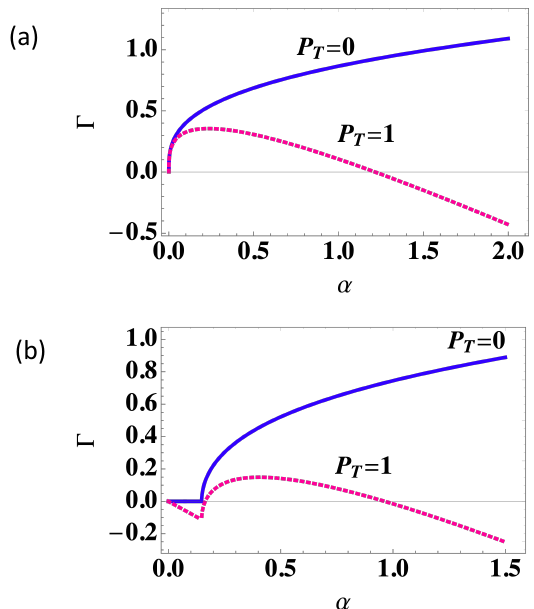
Figure 2. Thermal effects: Damping rate Γ = (cid:61) ( Ω ) , for a fixed value of (cid:60) ( Ω ) , as a function of the collective coupling parameter α , for a cold atomic gas, P T = 0, and for a thermal gas with P T = 1 (dashed curve): ( a ) in the absence of detuning, δ = 0; and ( b ) for a finite detuning, determined by δ =